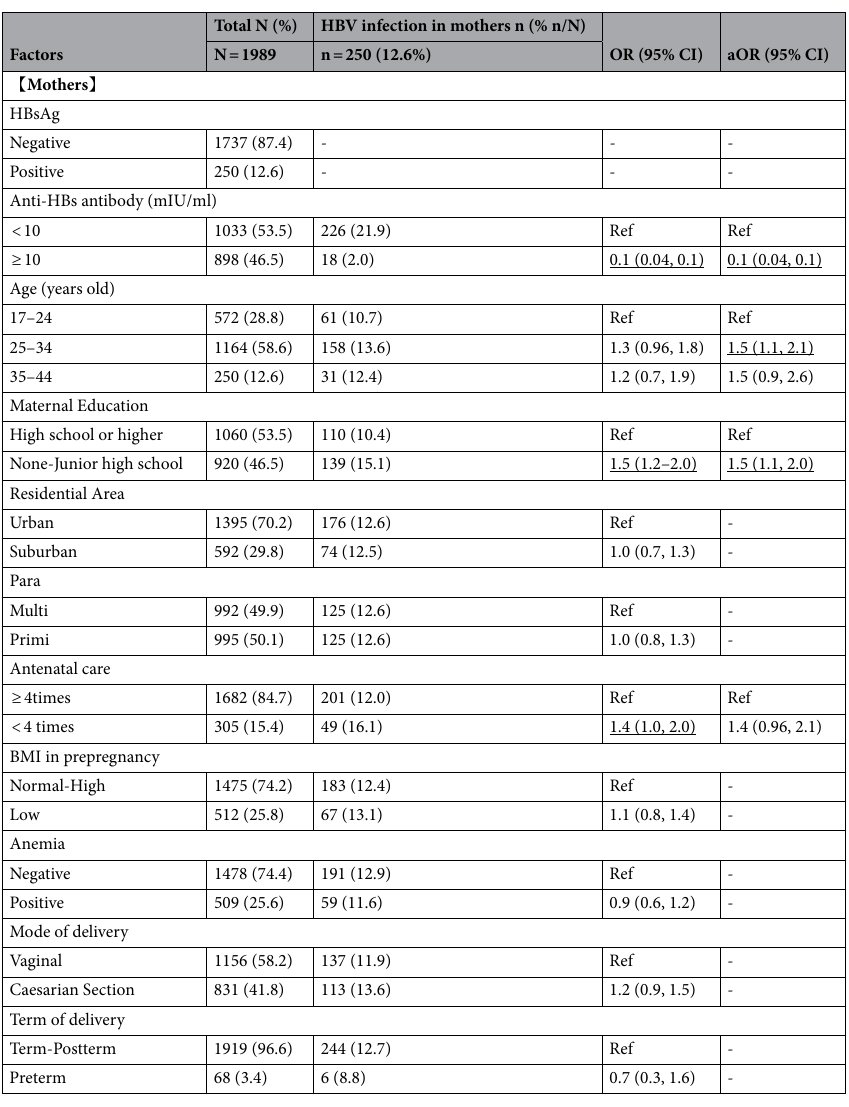
Table 1. Demographic characteristics and factors associated with HBV infection in mothers in the birth phase, Nha Trang, Vietnam, 2009–2010 (N = 1989). Logistic regression was used for projecting odds ratios (OR) in univariate analysis and adjusted odds ratios (aOR) in multivariate analysis. Variables with statistical significance were underlined when 95%CI of aOR did not include 1. HBsAg: hepatitis B surface antigen; HBV: hepatitis B virus; N: number; OR: odds ratio; CI: confidence interval; aOR: adjusted odds ratio; anti-HBs antibody: anti-hepatitis B surface antibody; HBeAg: hepatitis B e antigen; BMI: body mass index; and Ref.: